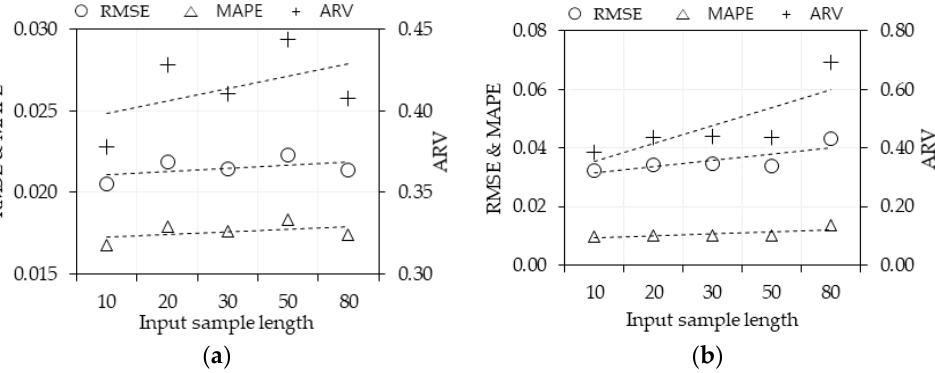
Figure 15. Estimation results of proposed model with different input sample lengths. The dashed line is the fitted trend line. ( a ) Direction along the river, ( b ) Vertical direction.